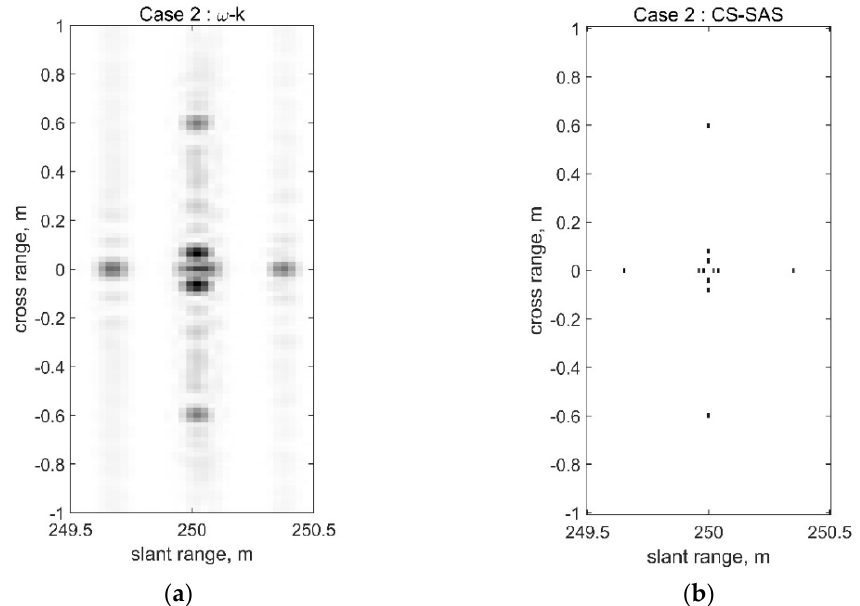
Figure 6. Simulation results for Case 2 for single sensor: ( a ) result for the ω -k algorithm; ( b ) result for the CS-SAS algorithm for single sensor.